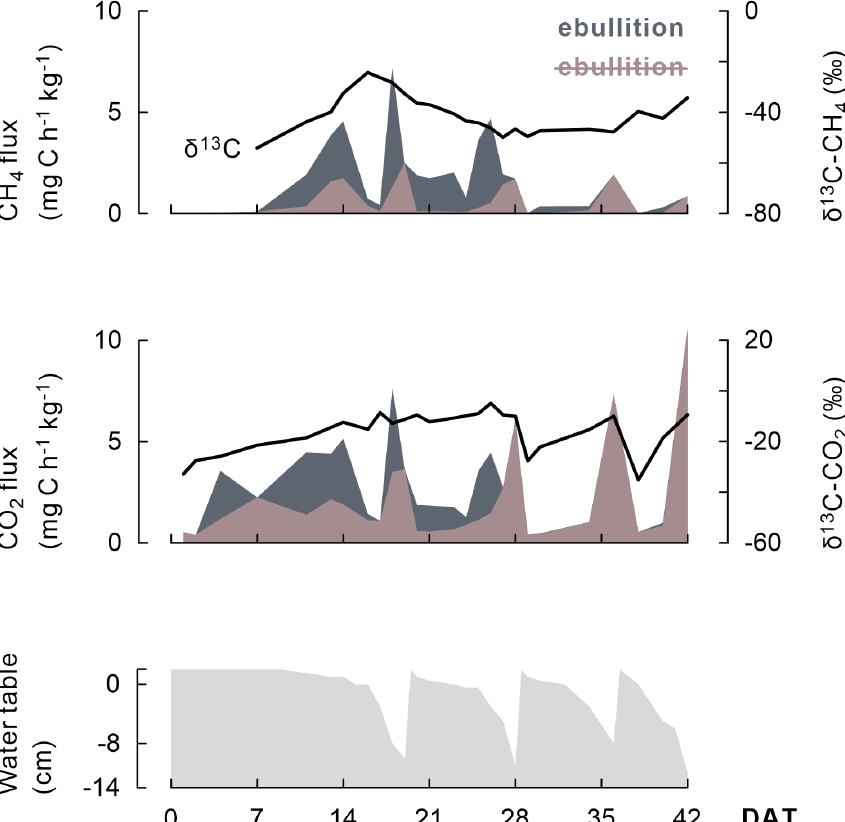
Figure 5. As this representative example (one replicate of the Balina soil with maize shoots added and under AWD) shows, the progression of CH 4 and CO 2 emission fluxes (shaded) and even their δ 13 C signature (black line) appear linked to the change in water table depth under AWD. A distinction is made between emission fluxes dominated by ebullition (dark grey shaded) versus by diffusion or plant transport (brown shaded). Transport through ebullition was particularly considerable when rice plants were juvenile.